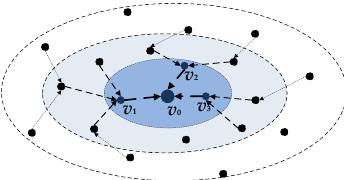
Figure 4. Community based on the pheromone of v 0 .